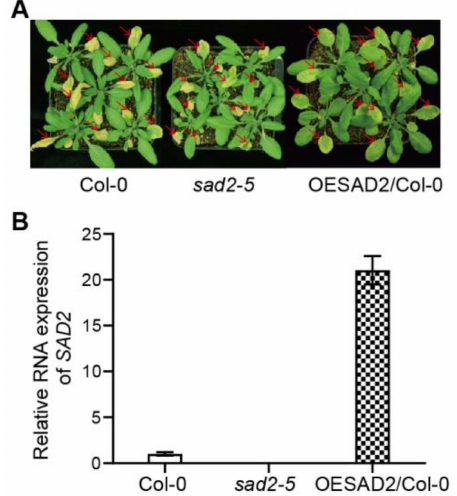
Figure 1. Disease symptoms and gene expression in Col-0, SAD2 knockout ( sad2-5 ), and SAD2 overexpression (OESAD2/Col-0) leaves after inoculation with Pseudomonas syringae pv. tomato ( Pst ) DC3000. ( A ) Disease symptoms at four days post-inoculation with Pst DC3000. Red arrows indicate inoculated leaves. ( B ) SAD2 expression in Col-0, sad2-5 , and OESAD2/Col-0